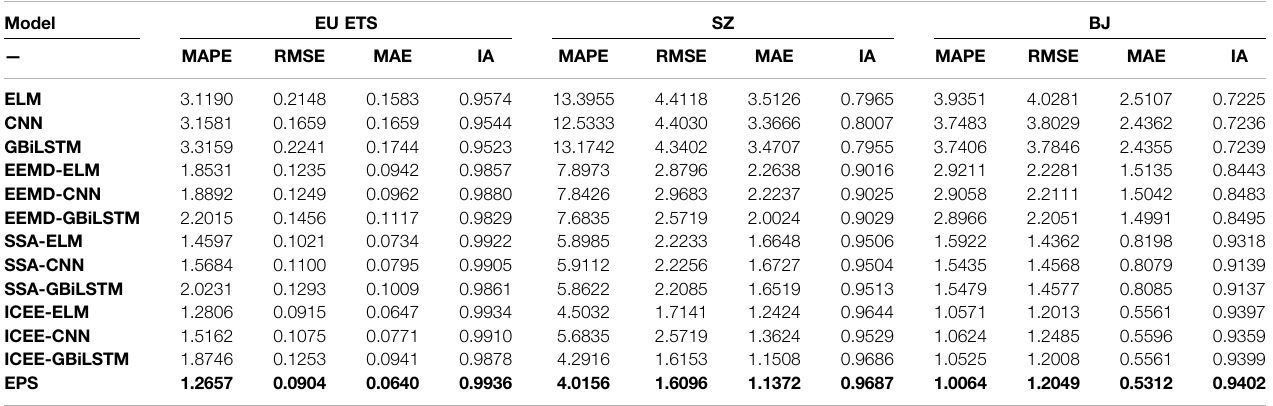
TABLE 6 | Comparison of the performances of prediction models based on different data feature extraction techniques. Model EU ETS